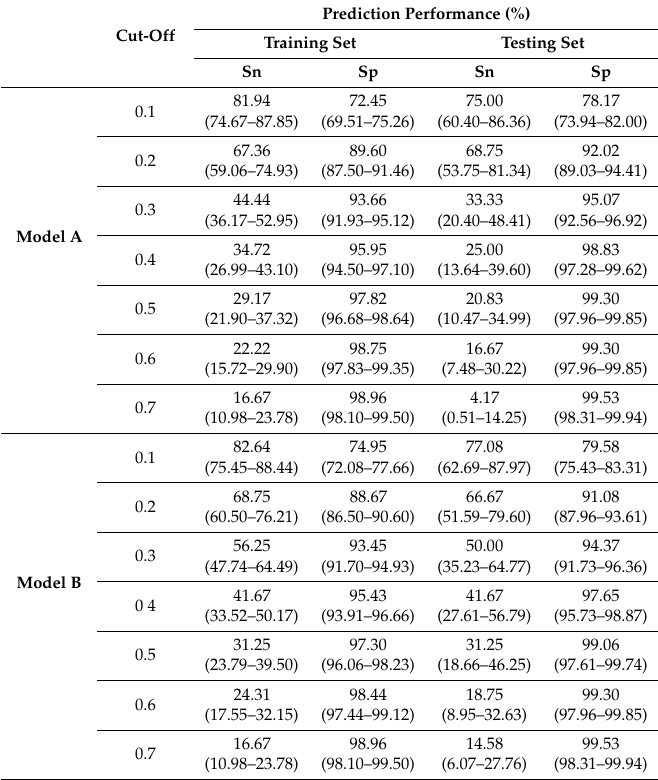
Table 7. Sensitivity and specificity of Model A and Model B at different cut-off values. Prediction Performance (%) Cut-Off Training Set Testing